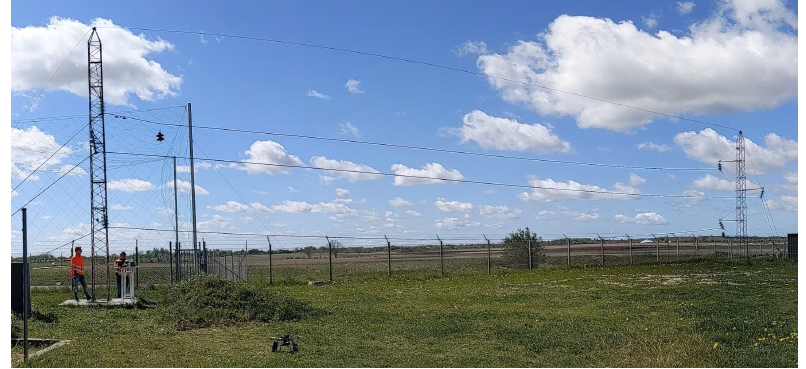
Figure 20. Drone testing setup at Hans Christian Andersen Airport in Odense,